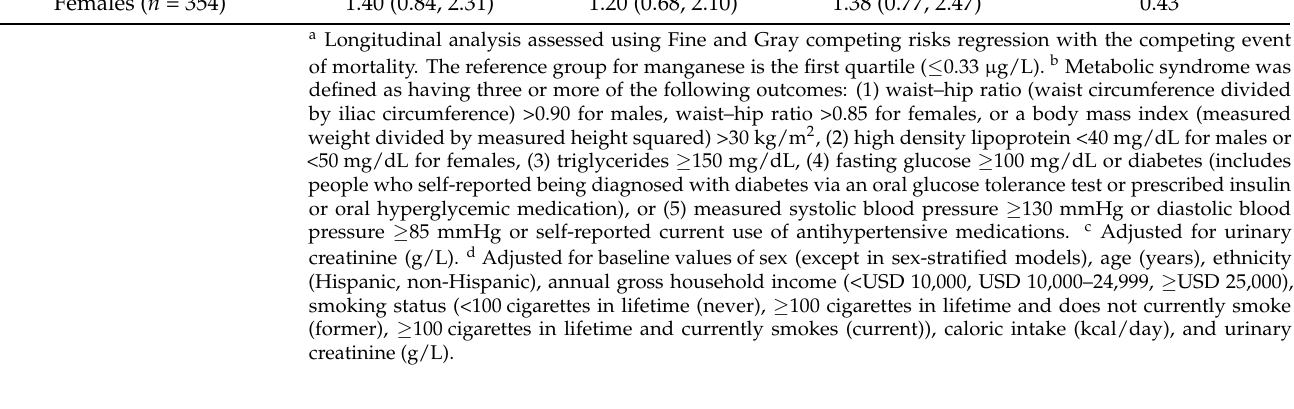
Table 3. Adjusted longitudinal associations a between baseline quartiles of manganese and metabolic